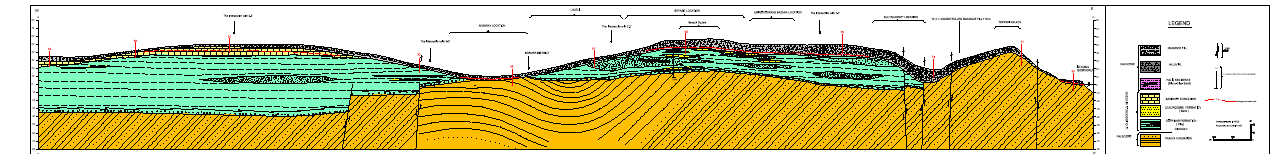
0 cross section where the 1-D and 2-D analyses were performed (˙Ince et al., 2008). Figure 7. The location of the points on the 5-5’cross section where the 1D and 2D analyses were performed (Ince et. al., 2008) Figure 7. The location of the points on the 5-5